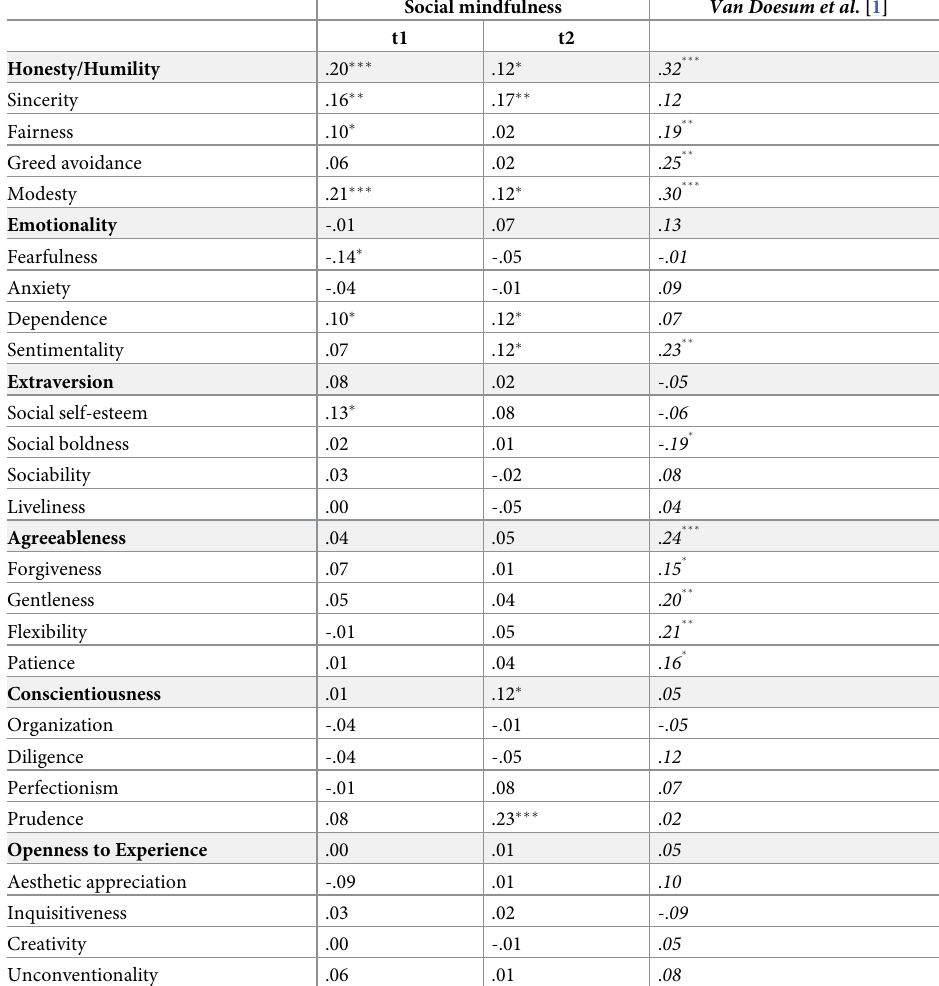
Table 1. Correlations between social mindfulness scores (First and second measurement occasions) and HEXACO dimensions and facets (First measurement